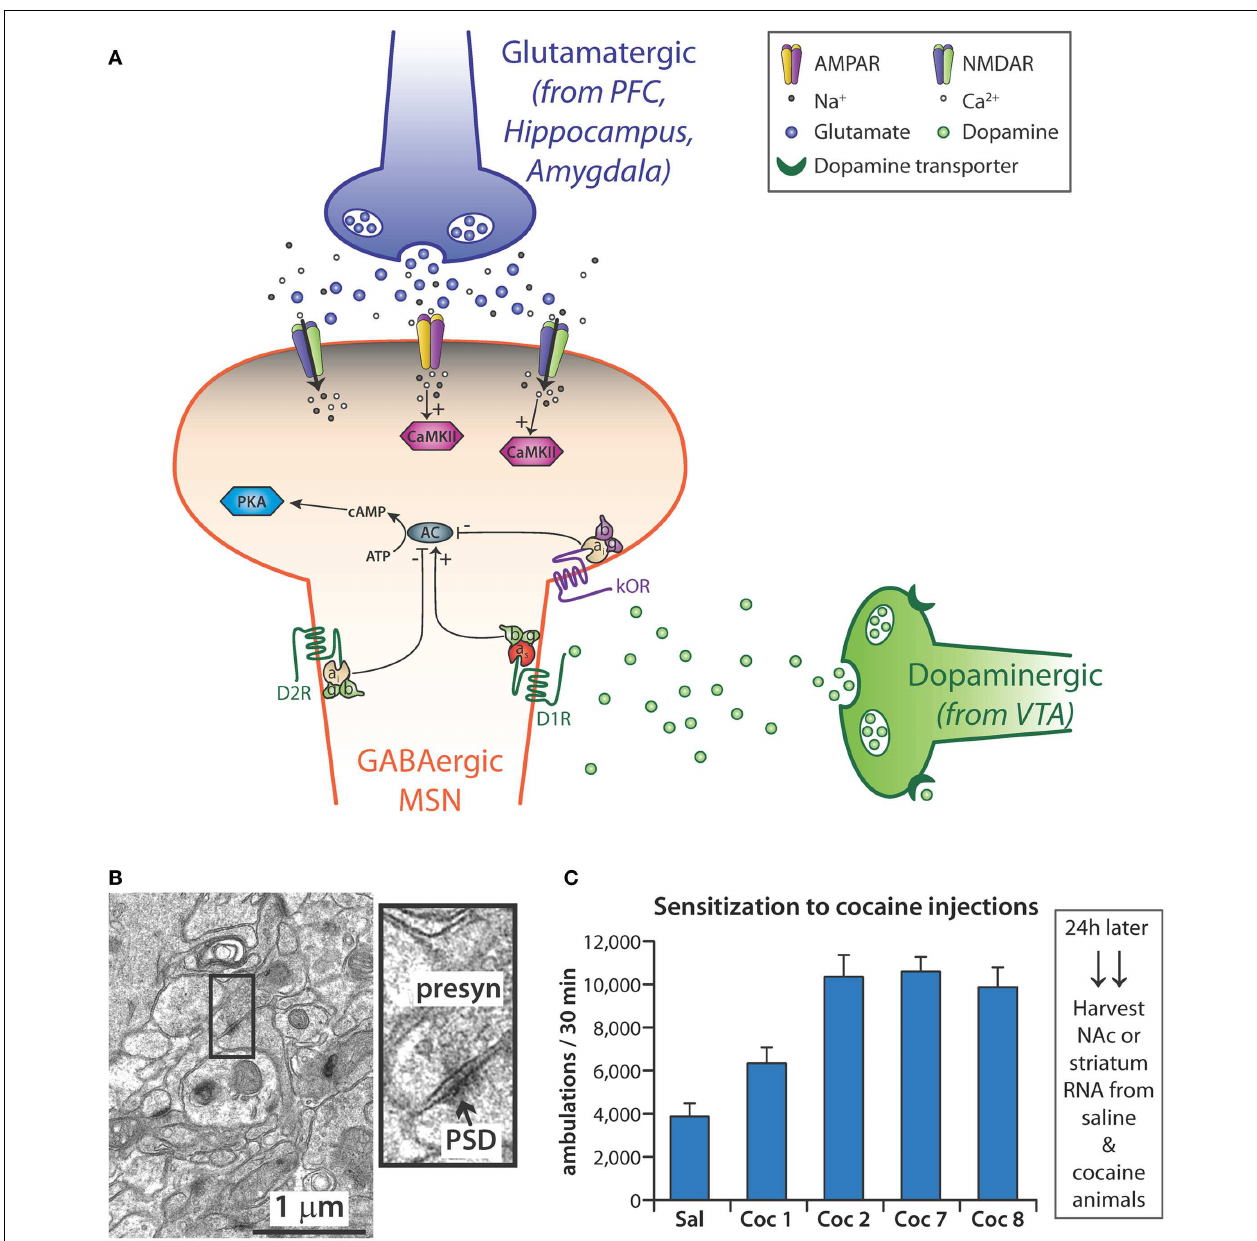
mouse hippocampus) illustrates the complex system from which PSDs must be purified: presynaptic terminals can be recognized by their content of synaptic vesicles; PSDs are closely apposed to the presynaptic endings. (C) Sensitization to the locomotor stimulating effects of cocaine requires repeated exposure to the drug. Adult mice typically are typically given 10–20mg cocaine/kg; locomotor activity (ambulations) is monitored for the next 30min in an activity chamber with infrared light sensors. “Sal” is the average locomotor data for all mice given saline initially and the mice given saline throughout; Coc1 are data for mice give 10mg/kg cocaine on day 1; Coc2 and Coc7 are data from days 2 and 7 for mice given 20mg/kg cocaine daily for days 2–7; Coc8 are the data for the cocaine treated mice given 10mg/kg on day 8; substantial locomotor sensitization is apparent compared to Coc1.Tissue harvested soon after drug administration allows analysis of the immediate response, while tissue harvested 24h after final drug administration allows evaluation of the steady state response. N = 10 each for saline and